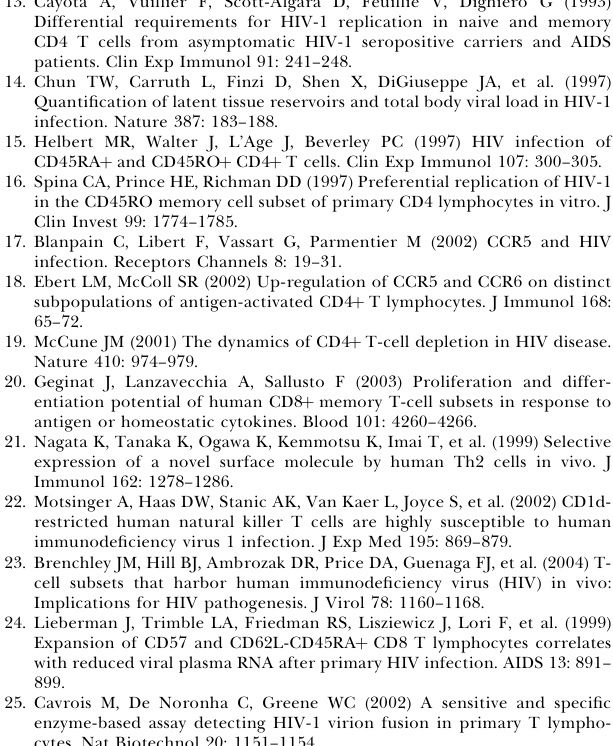
Figure S1. CRTH2 Expression on CD4 þ T Cell Subsets Purified CD4 þ T cells were stained with CD45RO and CCR7 in conjunction with the CRTH2 antibody. Electronic gates were set on T N , T CM , T EMRO , and T EMRA cells as described in Figure 1, and expression of CRTH2 was analyzed by flow cytometry. The results show mean expression from ten different individuals. Found at doi:10.1371/journal.ppat.0030058.sg001 (146 KB TIF). Figure S2. CCR5 Expression on CD4 þ T Cell Subsets PBMCs from HIV-positive individuals were stained with CD4, CD45RO, CCR7, and CCR5 antibodies. Electronic gates were set on CD4 þ T N , T CM , T EMRO , and T EMRA cells as described in Figure 1, and expression of CCR5 was analyzed by flow cytometry. The results show CCR5 expression from 20 different individuals. The median CCR5 expression levels were: T N ¼ 0.5, T CM ¼ 11.96, T EMRO ¼ 46, and T EMRA ¼ 25.1. Statistical significance was determined for T EMRO and T EMRA versus T CM using the Student’s two-tailed t test. * p , 0.05. Found at doi:10.1371/journal.ppat.0030058.sg002 (174 KB